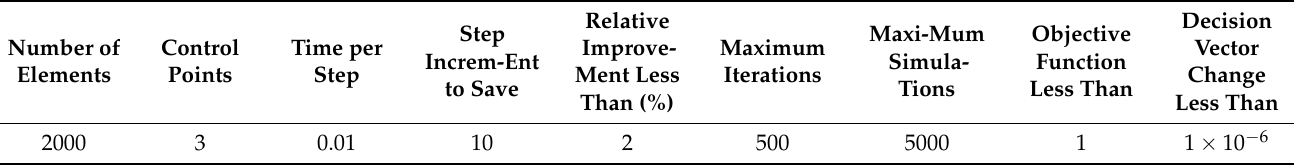
Table 4. The parameters of the simulation